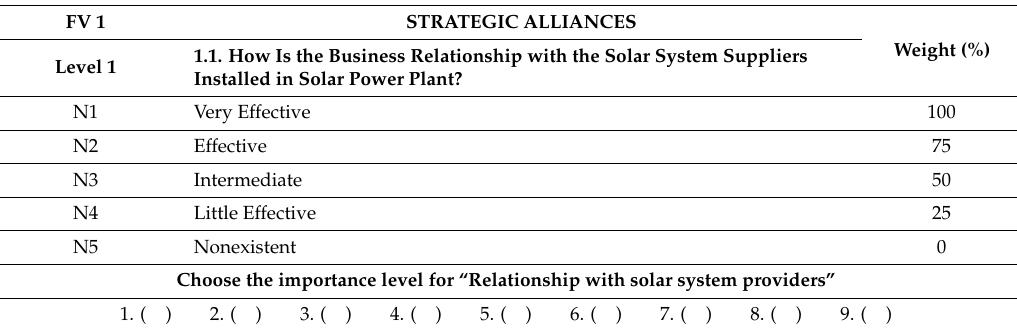
Table 2. Schematic representation of the research instrument.